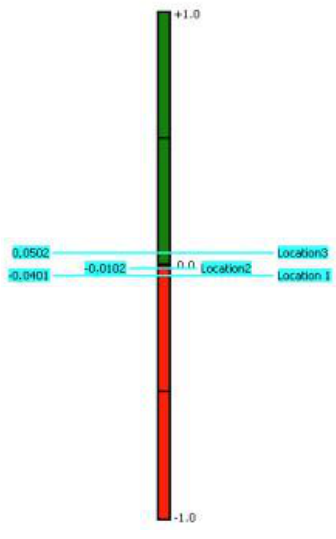
Figure 4. Results of PROMETHEE II—complete ranking.